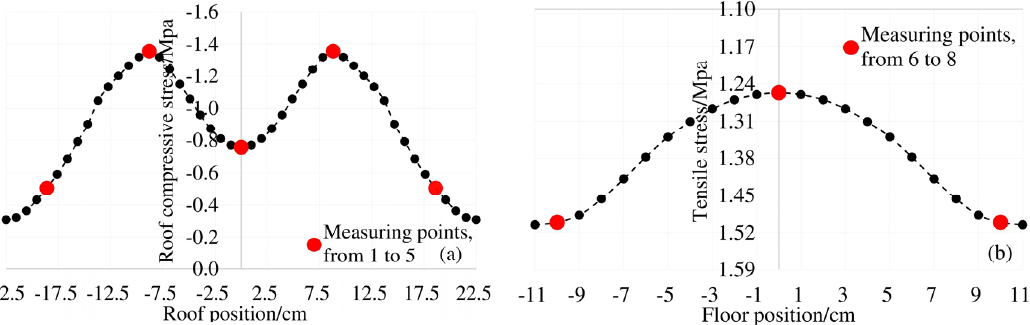
Figure 6. Shear lag effect of top and bottom plate under 0.8ft load: ( a ) stress distribution of roof; ( b ) stress distribution of floor.